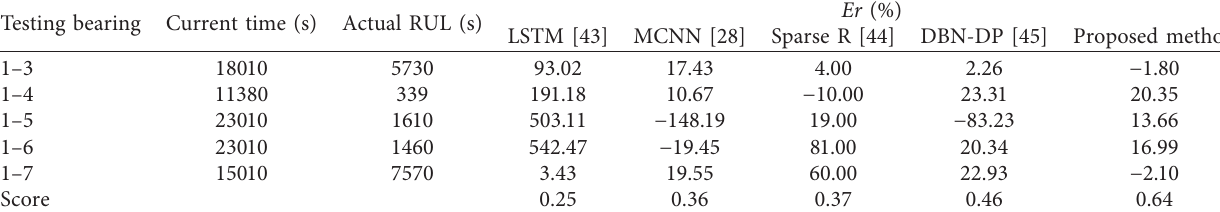
Figure 11: Evolution of the scoring function. Table 4: RUL estimation results and comparison.